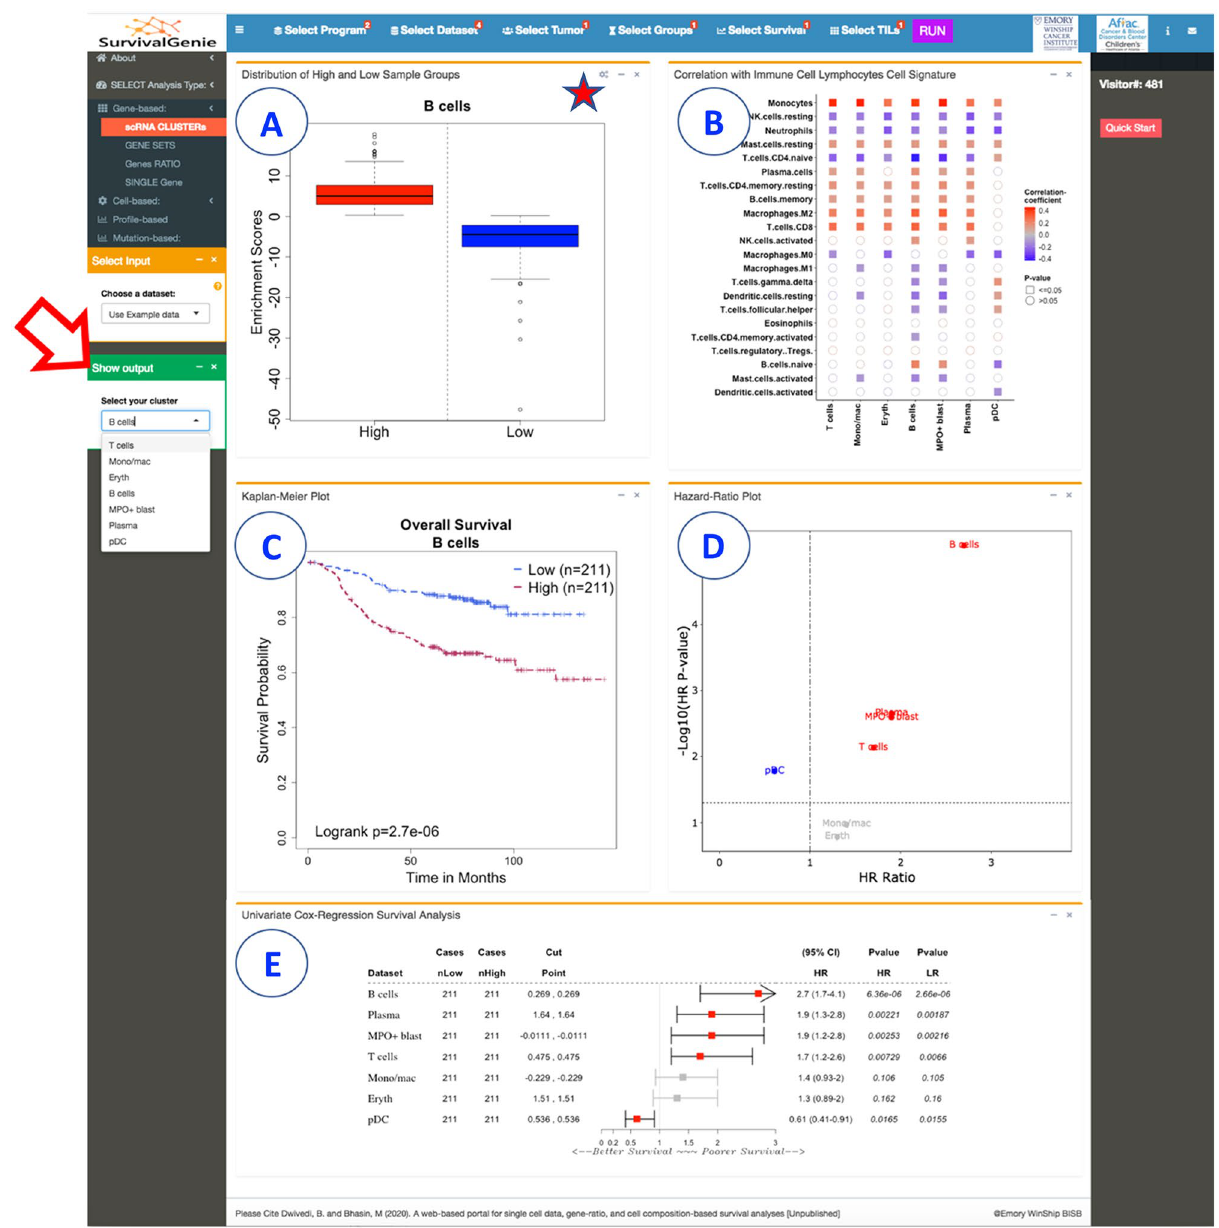
Meier, ( D ) hazard ratio, and ( E ) forest